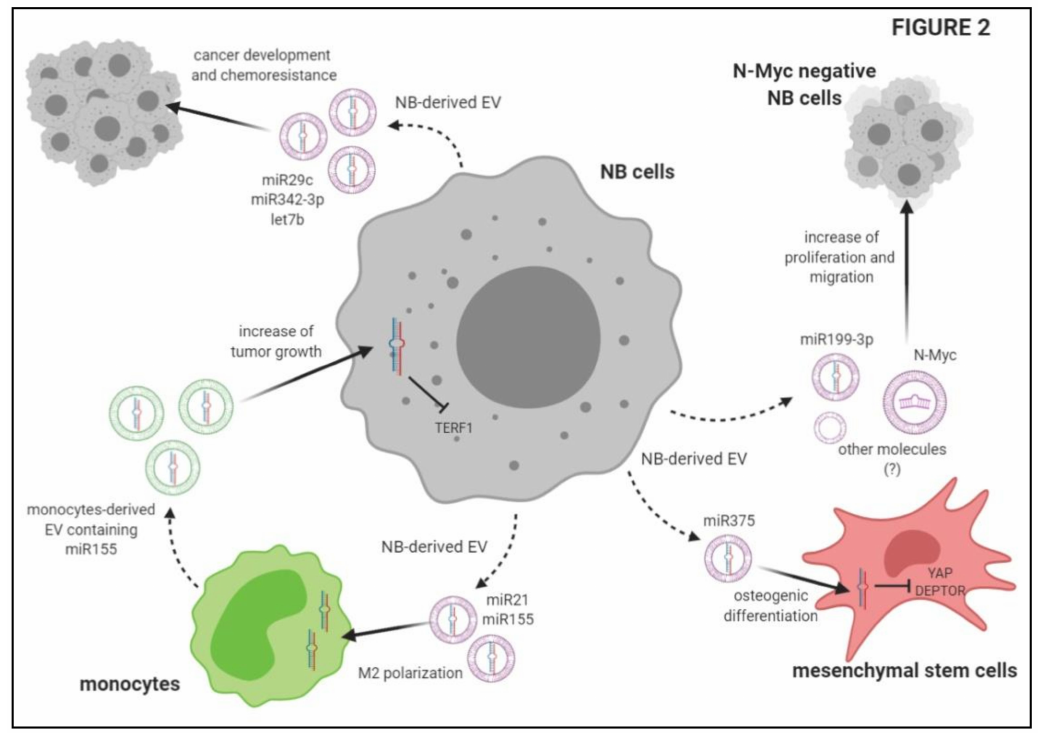
Figure 2. Schematic description of the mechanisms underlying the effects of extracellular vesicles on tumor growth and metastatic spread of Neuroblastoma